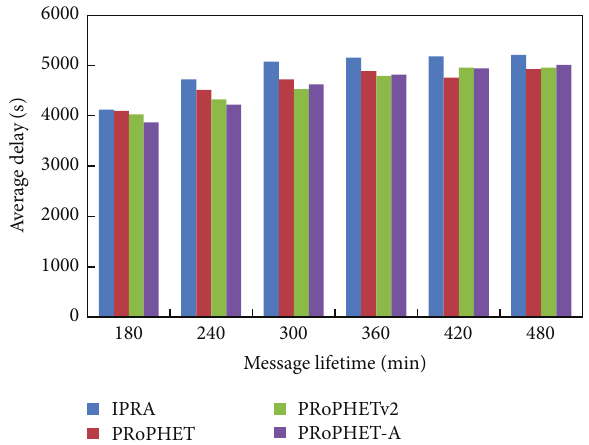
Figure 13: Average delivery rate (ADR) under different scenarios.